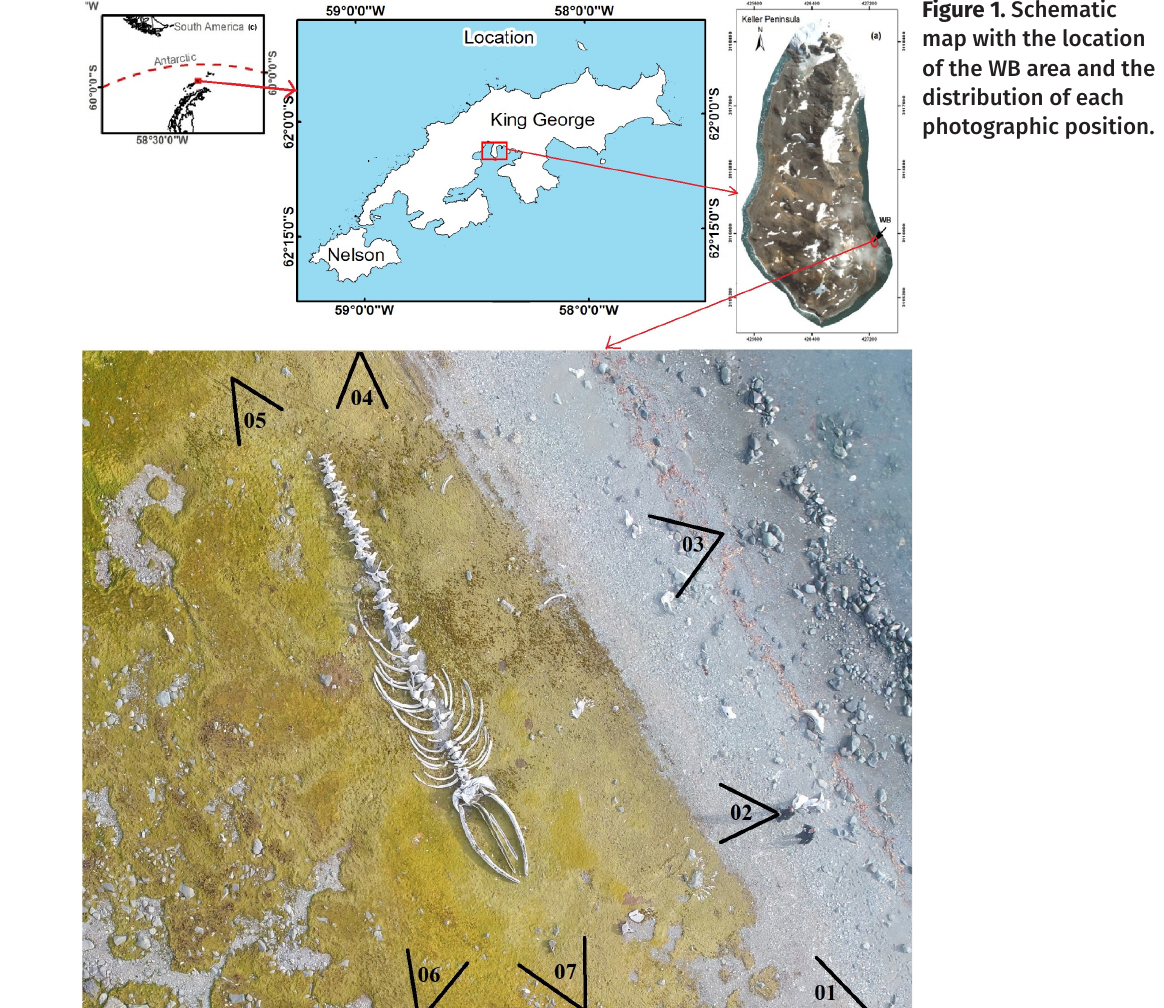
Figure 1. Schematic map with the location of the WB area and the distribution of each photographic